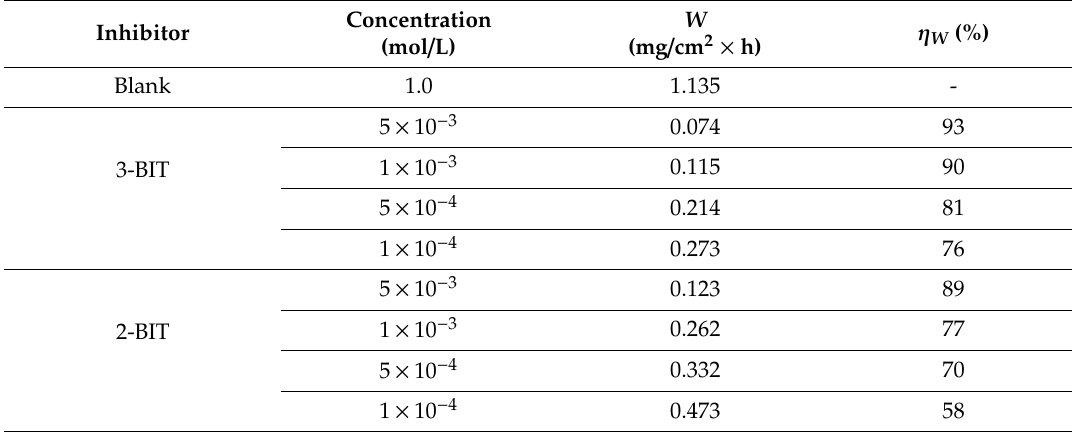
Table 1. E ff ect of 2-BIT and 3-BIT concentrations on corrosion data of mild steel in 1.0 M hydrochloric (HCl) at 303